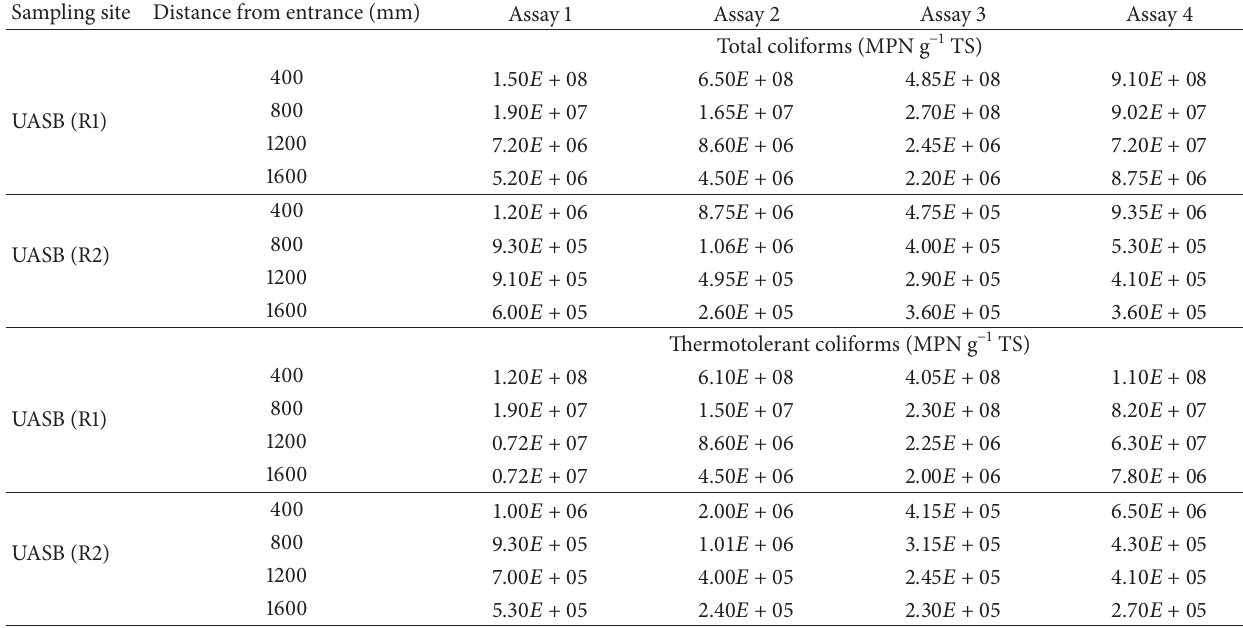
Table 4: Average of the most probable number (MPN g −1 TS) of total and thermotolerant coliforms in the sludge of the UASB reactors placed in series, at pilot scale of treatment system I, in assays 1, 2, 3, and 4. Sampling site Distance from entrance (mm)